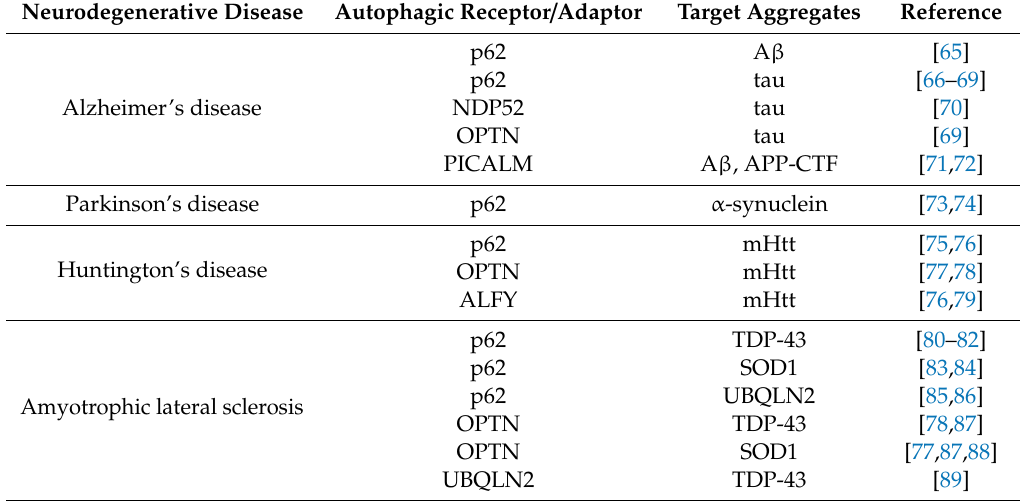
Table 1. Association between various autophagic receptors / adaptors and neurodegenerative